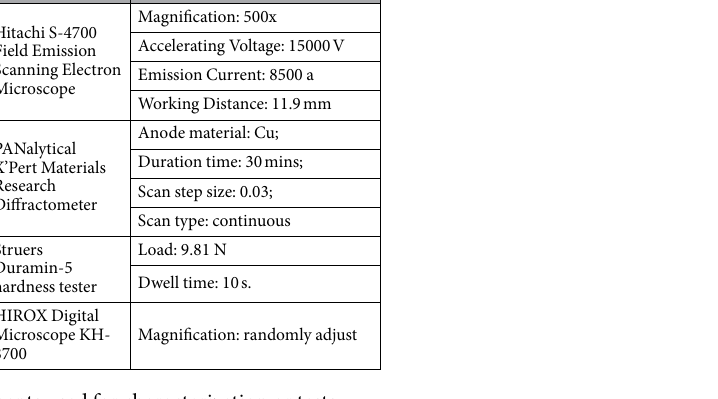
Since the four types of powders have different powder morphology, different size distribution, and different densities, the powder feed rates are different under the same argon gas flow rate. The powder flow rates were quantified in Table 4. With the argon gas flow rate of 6 m/s, the powder feed rates for all the powders were consist- ent over the entire printing process. The laser 3D printer set-up used in this study consists of the following units: a laser system which provides the heat source, a powder feeding system with a ceramic nozzle, and a linear motor system. (1). an IPG Photonics continuous wave (CW) fiber laser system with a 1.064 μ m wavelength was used as the laser heat source. The laser system can provide at most 1000 W laser output power. (2). A commercial powder feeder (Bay State Surface Technologies, Inc, Model-1200) was employed to supply powder in this study. The inert Argon gas was used to carry the powder through the pipeline system, then sprayed through an Al2O3 ceramic nozzle. (3). Three linear motors (AEROTECH, Inc, Model-100SMB2) were employed to generate moving path so that the thin wall sample could be fabricated layer by layer.